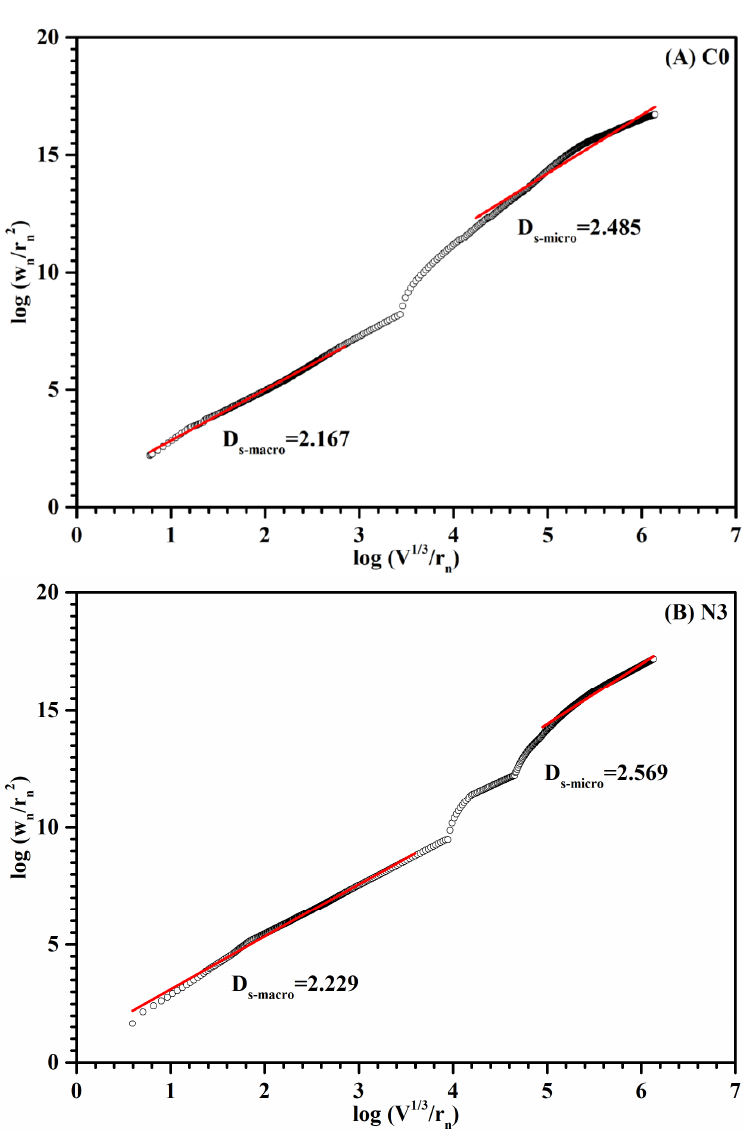
Figure 12. The relation between W n /r n2 versus V n1/3 /r n for sample ( A ) C0 and ( B ) N3 at 28 days.